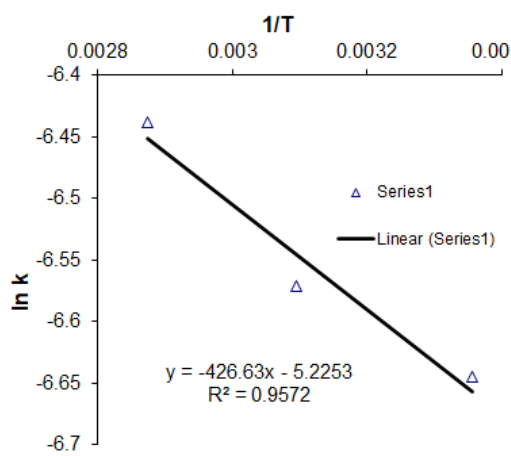
Figure A1. Arrhenius chart for OSA compacts. Table A2. Reaction parameters for OSA compacts.